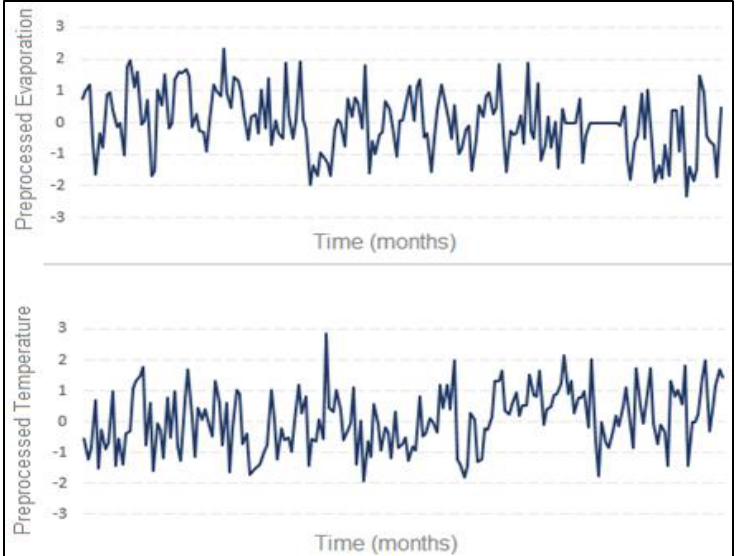
Figure 7. Evaporation and temperature time series for the period from January 2004 to June 2019.